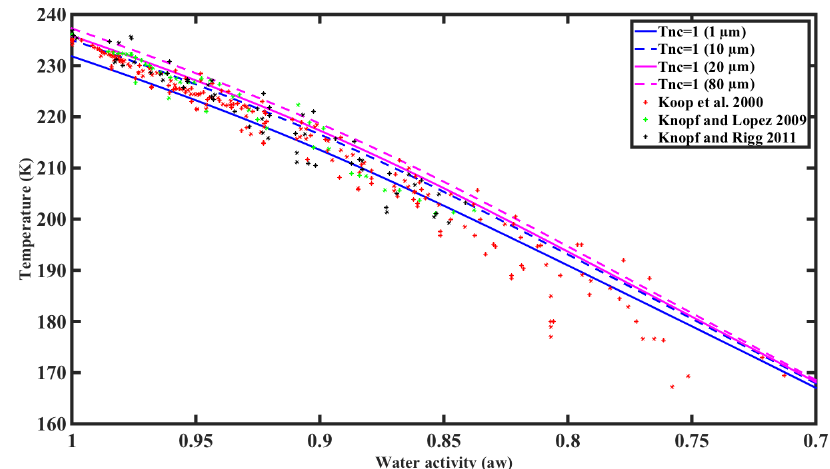
Figure 4. Comparison between the experimental data of freezing temperatures of solution droplets (Koop et al., 2000; Knopf and Lopez, (V,a w ) (using σ i / w , e from TIP4P 2009; Knopf and Rigg, 2011) and the approximation T N c = 1